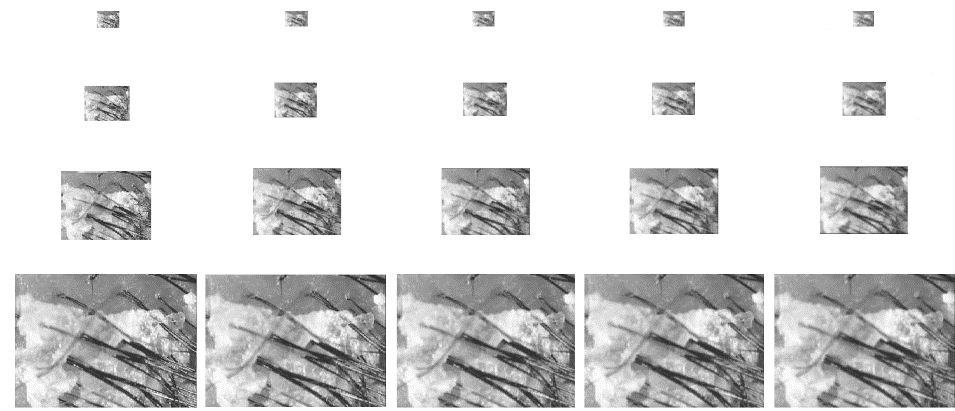
Figure 13. Dandruff image is displayed at four octaves with five standard deviations.